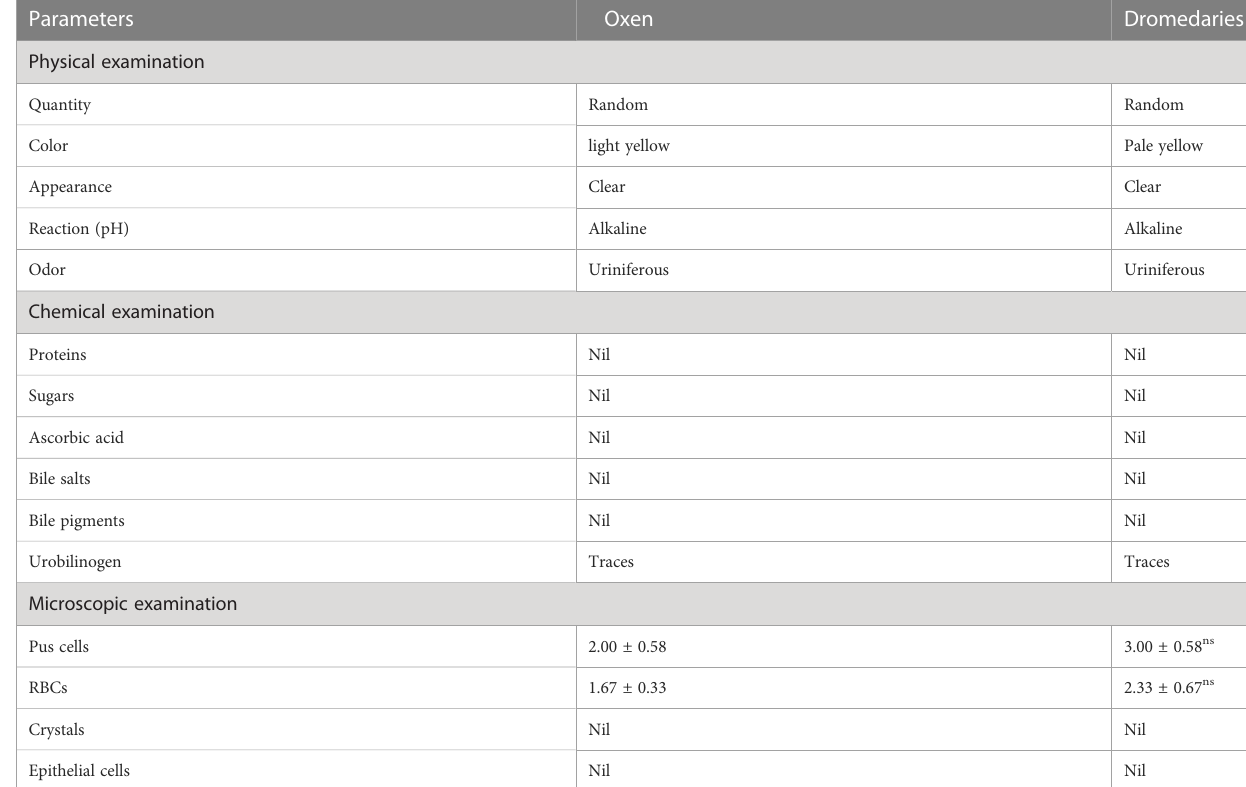
TABLE 1 Physical, chemical, and microscopical characteristics of the urine in oxen and dromedaries (n=20 each).